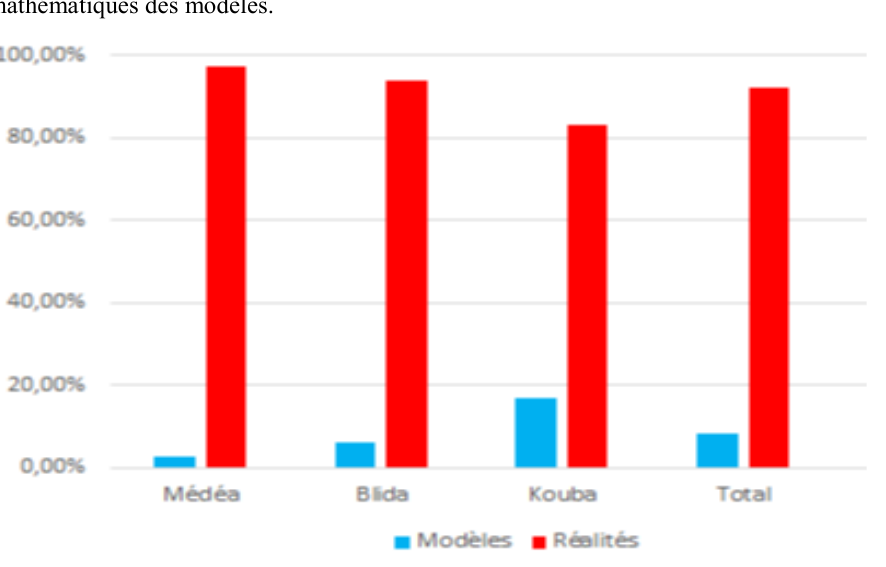
Fig. 4-a. Résultats de l’item 4.a. La différenciation entre modèle et réalité.